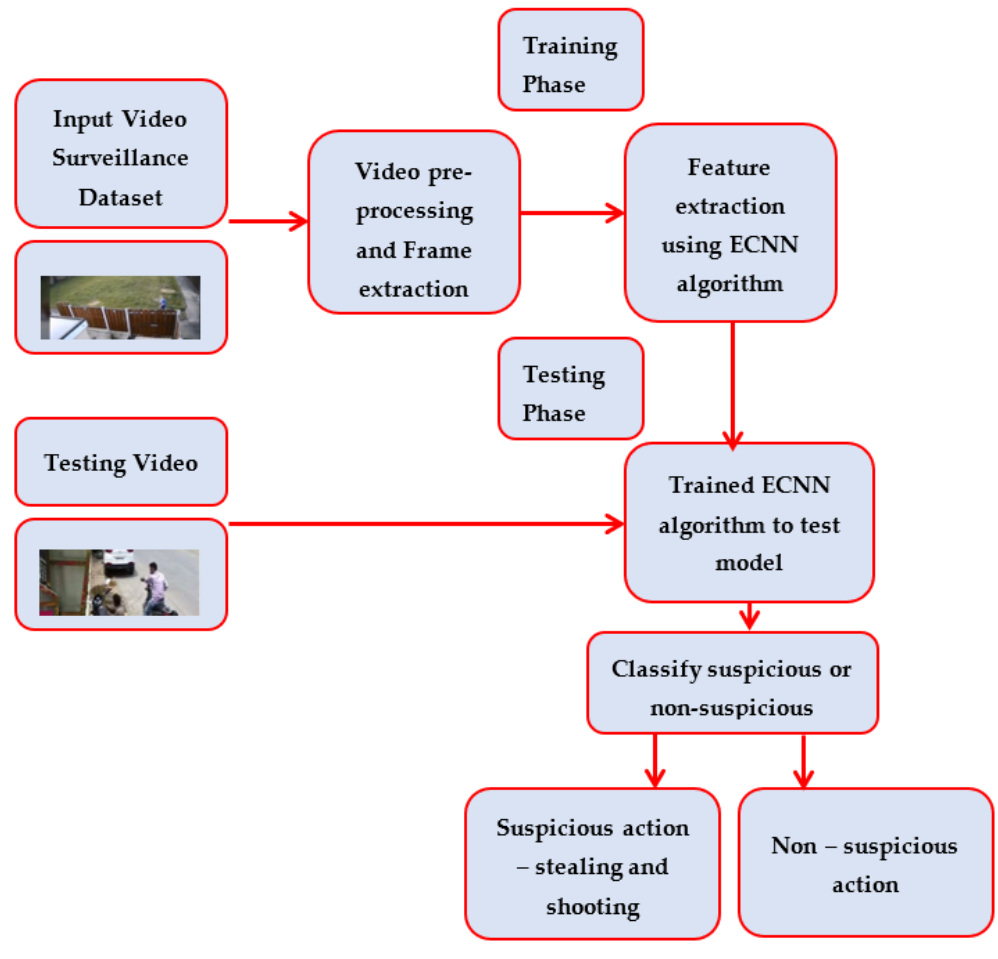
Figure 4. Suspicious and non ‐ suspicious action with training and testing procedure.